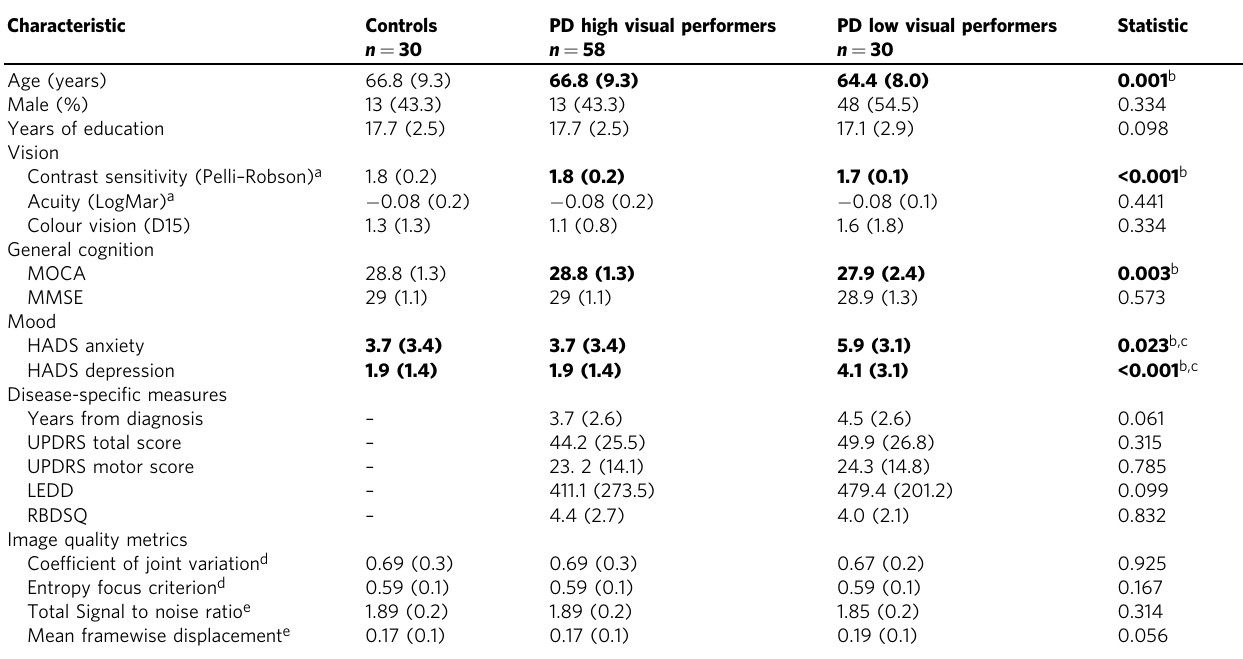
Table 1 Demographics and clinical